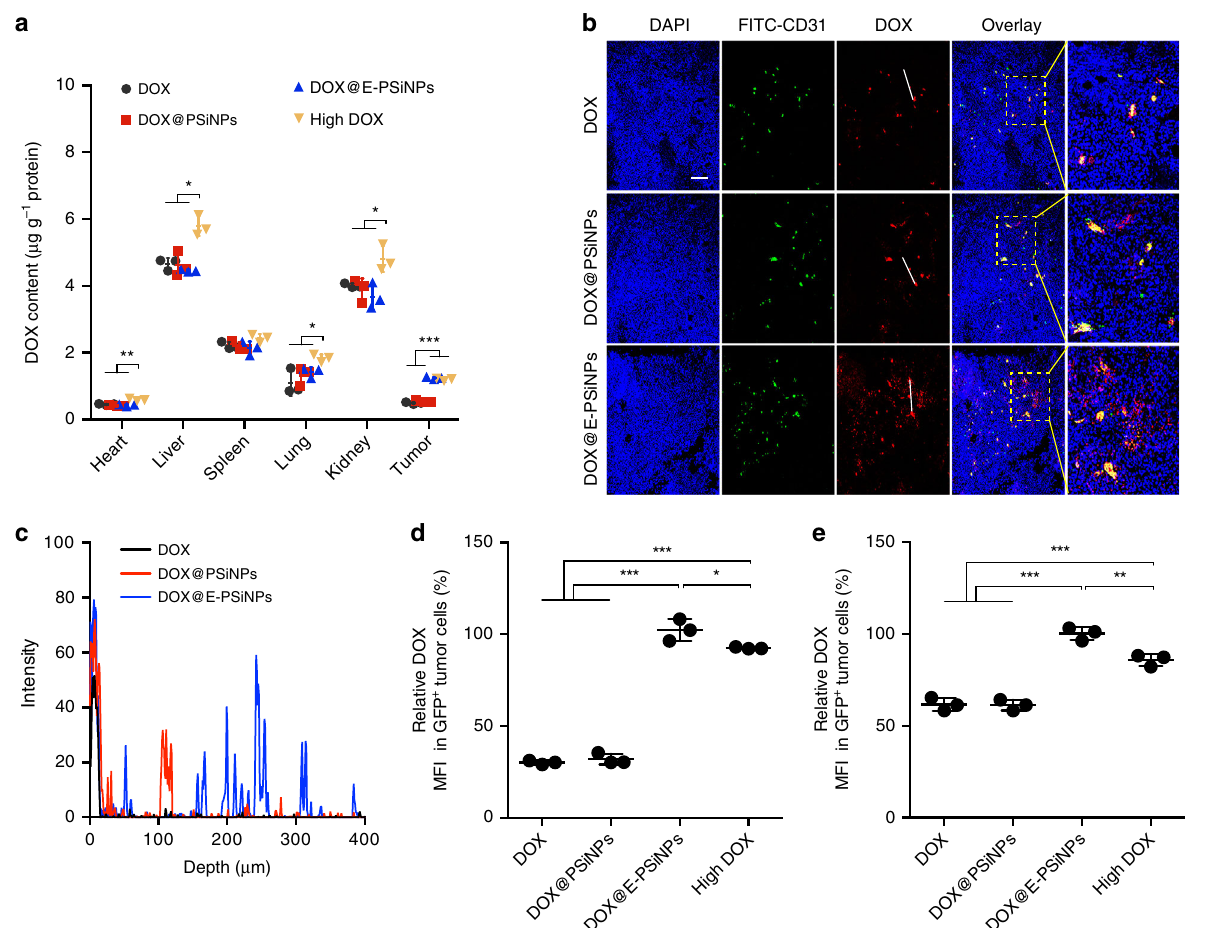
Fig. 6 Accumulation and penetration of DOX@E-PSiNPs into tumor parenchyma. a DOX content in tumor tissues and major organs of H22 tumor-bearing mice at 24 h after intravenous injection of DOX, DOX@PSiNPs or DOX@E-PSiNPs at DOX dosage of 0.5 mg kg − 1 , or high dosage of DOX at 4 mg kg − 1 . b Colocalization of DOX and CD31-labeled tumor vessels in tumor sections of H22 tumor-bearing mice at 24 h after intravenous injection of DOX, DOX@PSiNPs or DOX@E-PSiNPs at DOX dosage of 0.5 mg kg − 1 . Scale bar: 200 µ m. White lines represent the distance between DOX in blood vessels and DOX in tumor parenchyma. c DOX distribution pro fi le from the blood vessels to tumor tissues on the speci fi ed white lines as indicated in b . d , e Relative DOX fl uorescence intensity in GFP-positive tumor cells ( d ) and side population cells ( e ) of tumor tissues at 24 h after GFP-expressing H22